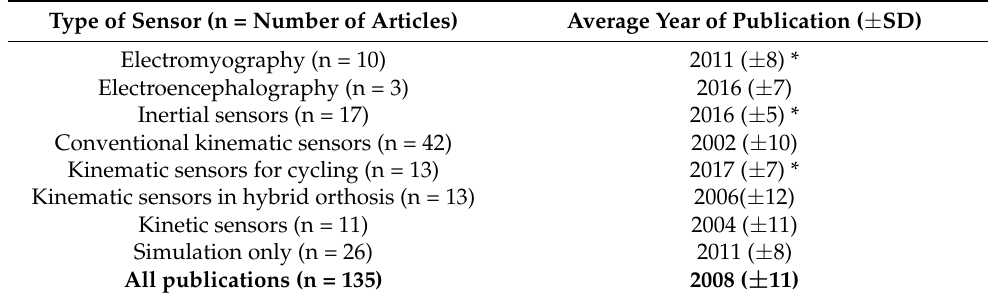
Table 1. Average year of publication for each type of sensor used in the FES system. Type of Sensor (n = Number of Articles)